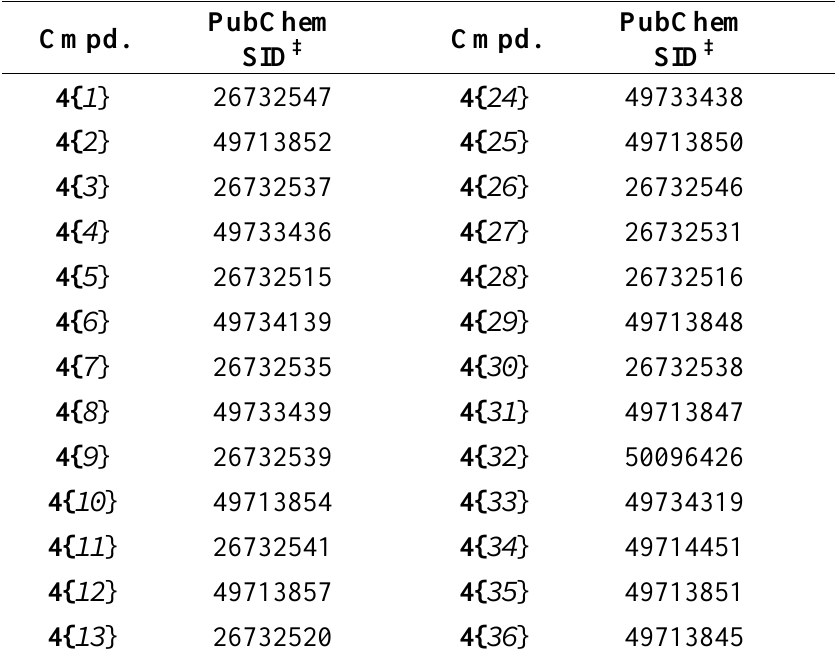
Table 5. Cross reference guide for library members with the PubChem database (SID identification